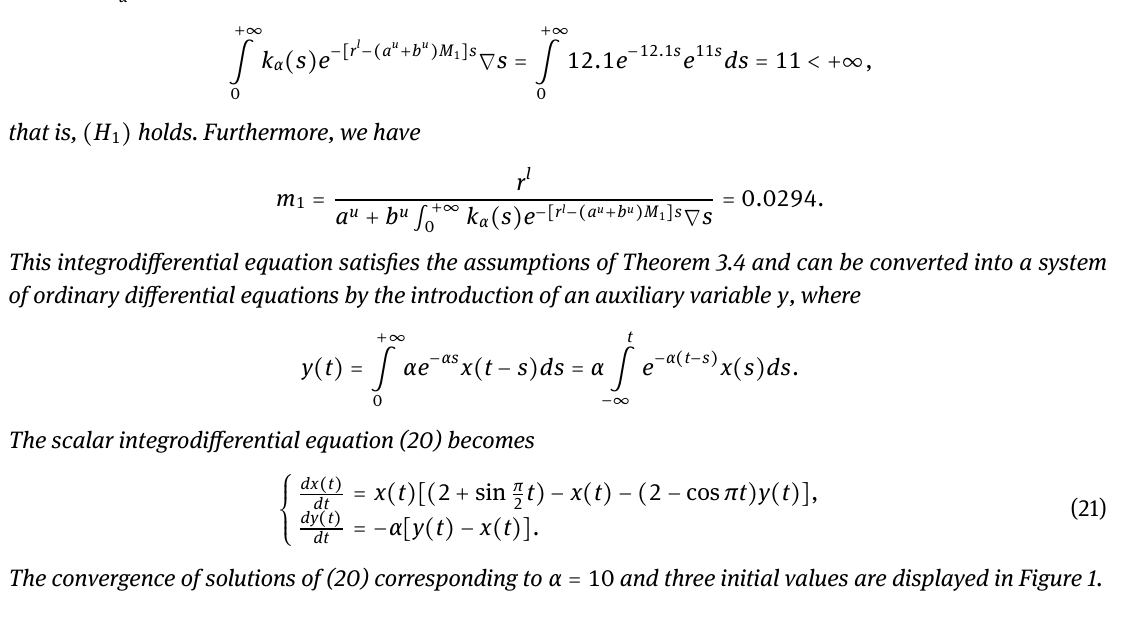
Fig. 1. Graphs of the solution x ( t ) of (21) with α = 10 and the initial values ( x ( 0 ) , y ( 0 )) = {( 0.1,0.1 ) , ( 1,1 ) , ( 2,2 )}